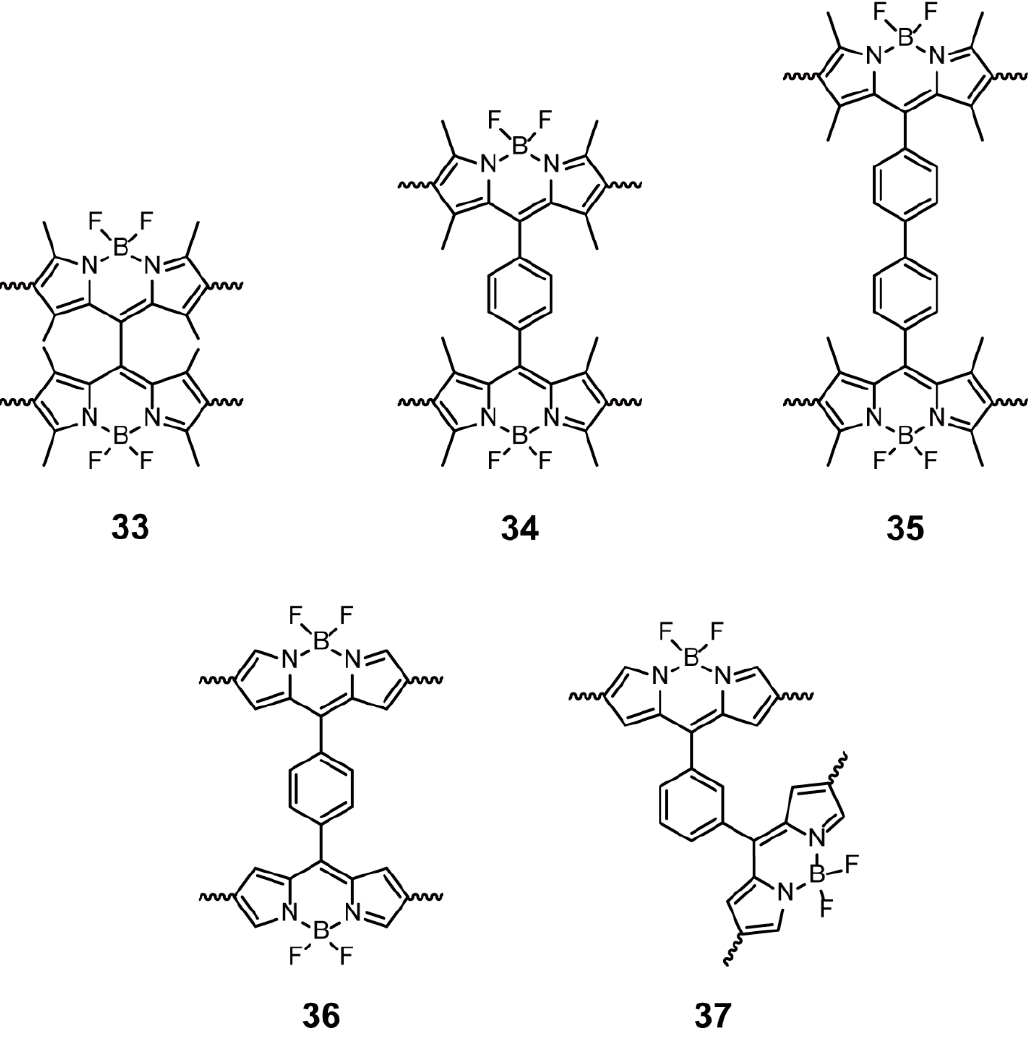
Figure 12. Chemical structures of polymers 33 – 37 (Reproduced with permission from Reference [65]. Copyright @ 2017 WILEY-VCH Verlag GmbH & Co. KGaA, Weinheim. Reproduced with permission from Reference [66]. Copyright @ 2017, Royal Society of Chemistry).